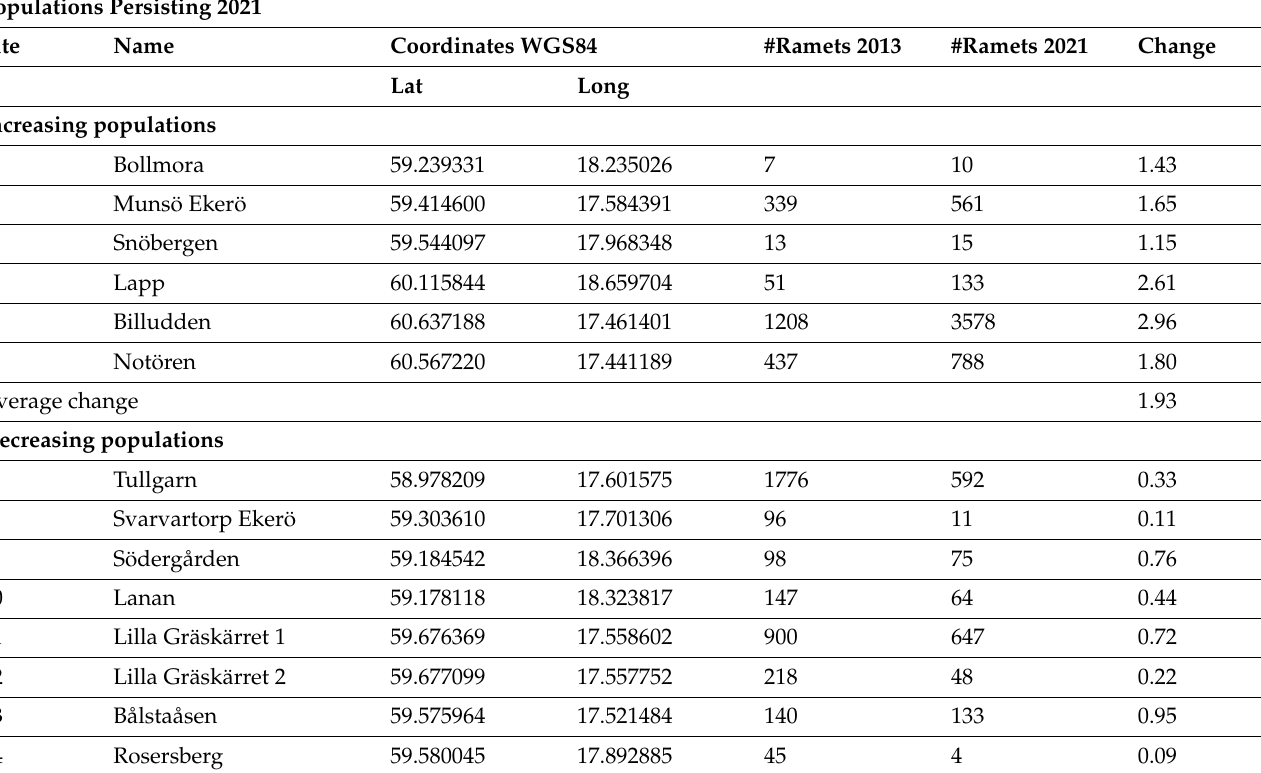
Table A1. Results from a re-survey conducted in 2021 of Chimaphila umbellata populations recorded in 2013 [114]. In 2013, 38 sites were investigated, among which Chimaphila was found at 34 sites. These 34 sites were re-surveyed in July 2021. The exact location and identity of four of these sites were however uncertain and they were therefore excluded. Of the 30 remaining sites, Chimaphila was not found at eight sites, and the populations were interpreted as extinct. The survey-data is listed below, divided into those sites where the population had increased (Site 1–6), decreased (Site 7–22), and was extinct (Site 23–30). The average number of ramets in 2013 in still persistent populations (Site 1–22) was 313 (range 7–1776), and in extinct populations (Site 23–30) it was 75 (range 1–314) (Z = 1.99, p = 0.0466; Mann–Whitney U -test). ‘Change’ is the ratio #ramets 2021/#ramets